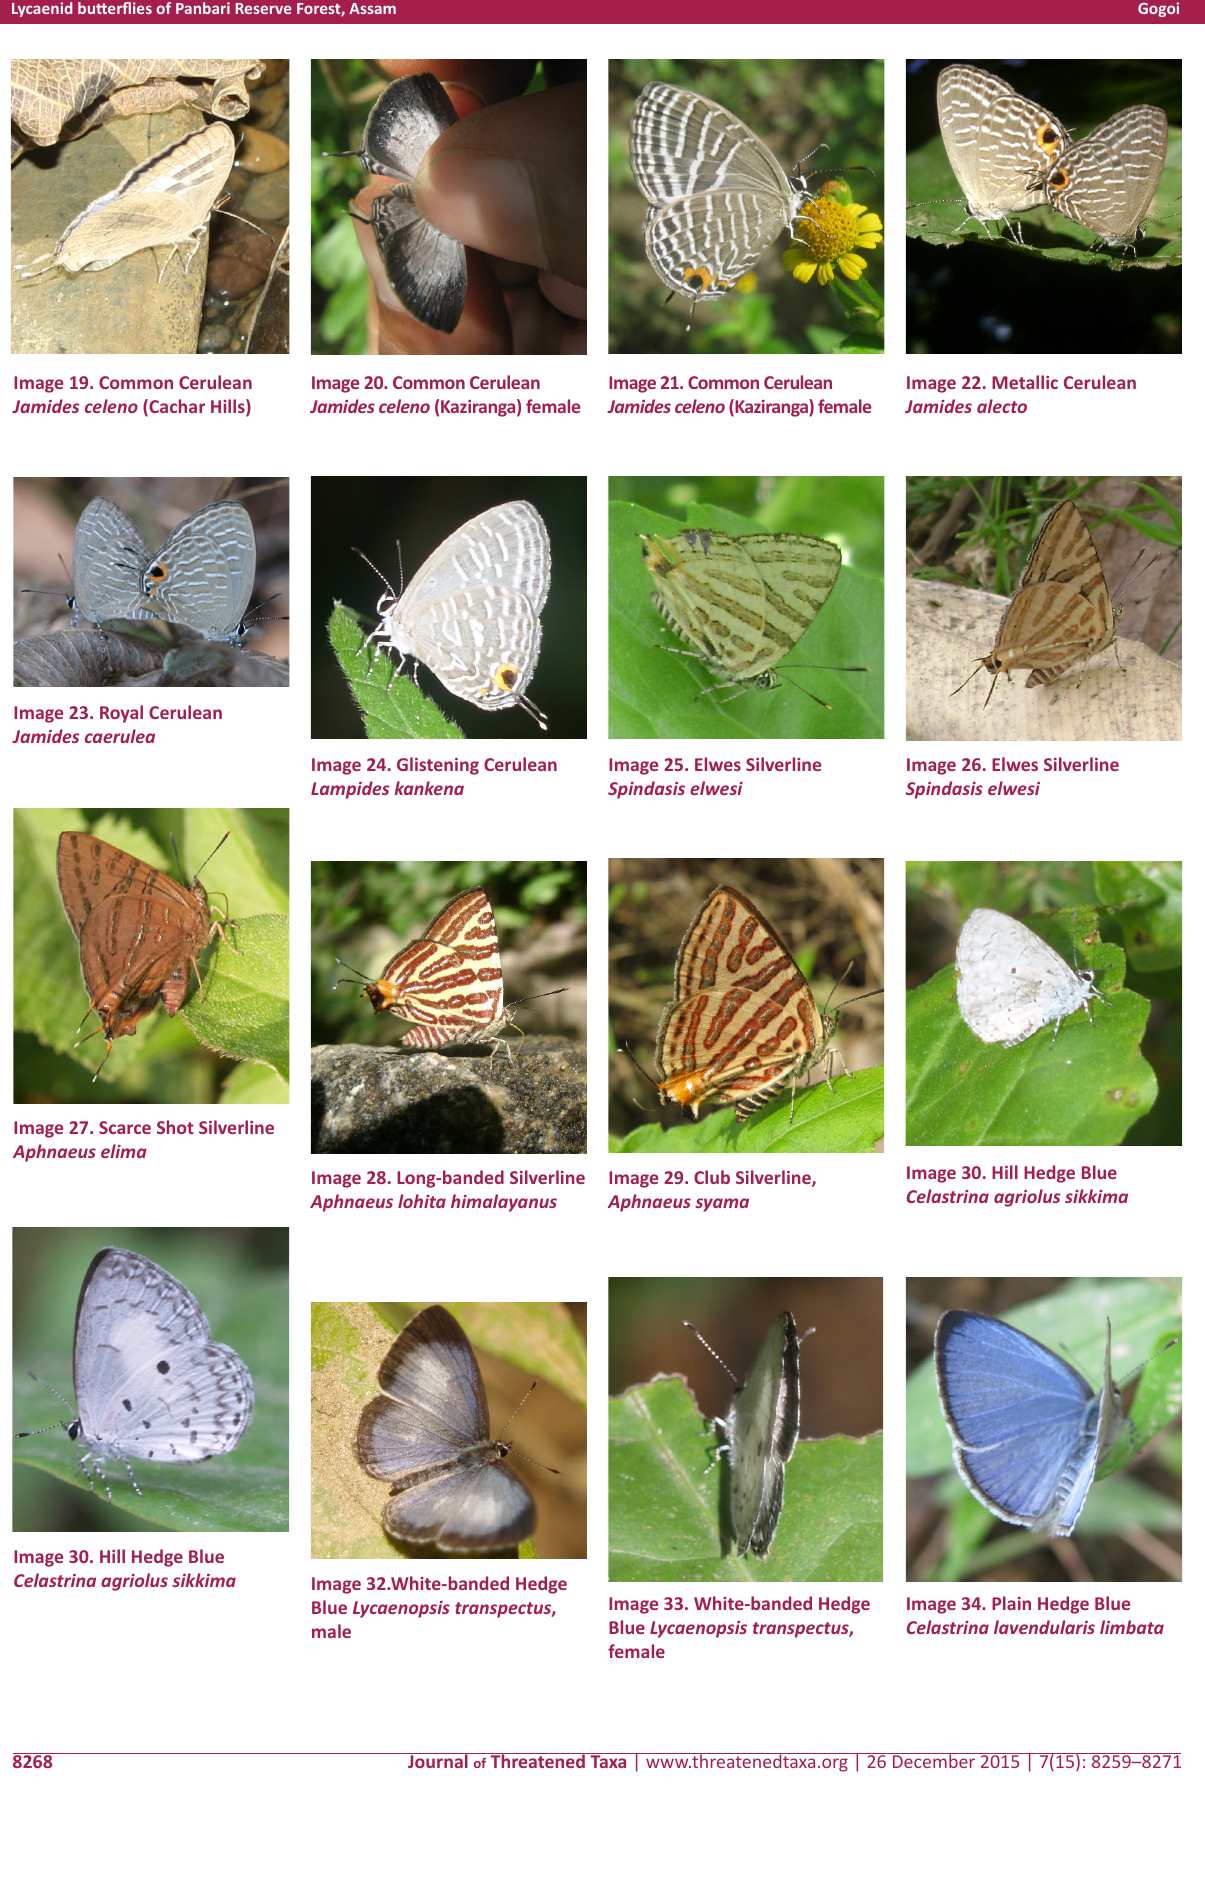
Image 33. White-banded Hedge Blue Lycaenopsis transpectus , female